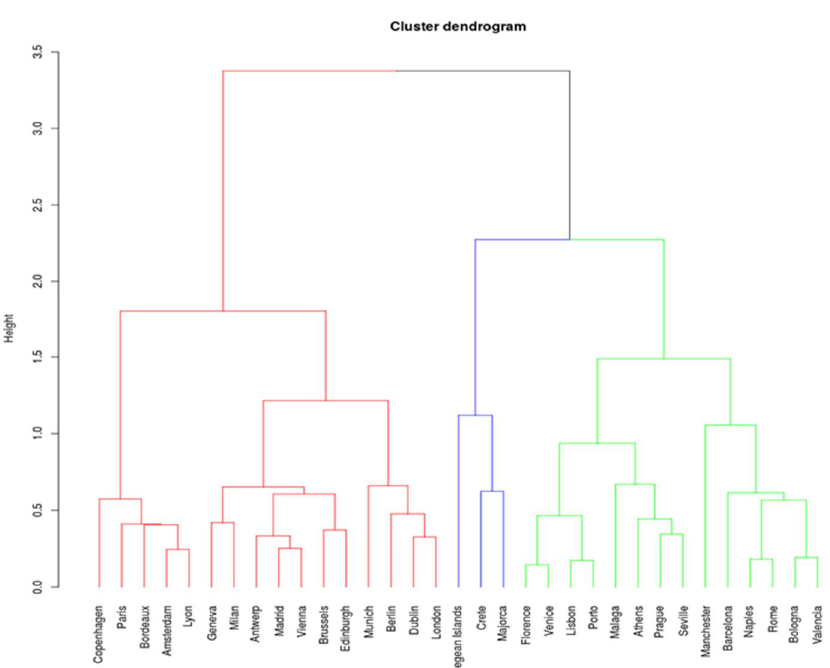
Figure 3. Dendrogram Ward’s method and Euclidean distance. Source: author’s own elaboration. The dendrogram graphically depicts the distances between cities found in each cluster.